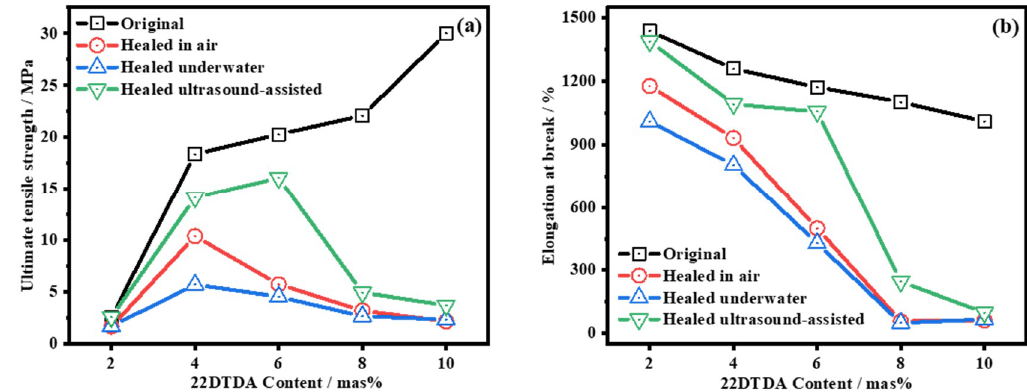
Figure 10. The surface morphologies of P22-2 ( a ), P22-4 ( b ), P22-6 ( c ), P22-8 ( d ), and P22-10 ( e ) after underwater treatment for 4 h. The surface morphologies of P22-2 ( a’ ), P22-4 ( b’ ), P22-6 ( c’ ), P22-8 ( d’ ), and P22-10 ( e’ ) following ultrasonication. The cumulative ultrasound time was 30 min based on a sonication cycle of 20 s off intervals followed by 10 s of work.